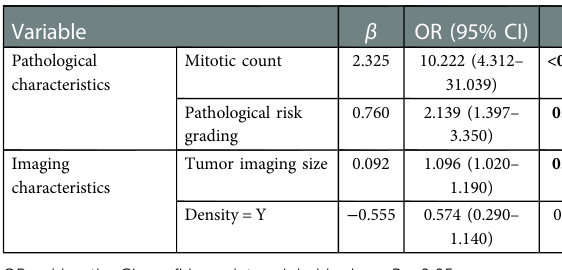
TABLE 3 Results of univariate logistic regression analysis. TABLE 4 Results of multivariate logistic regression